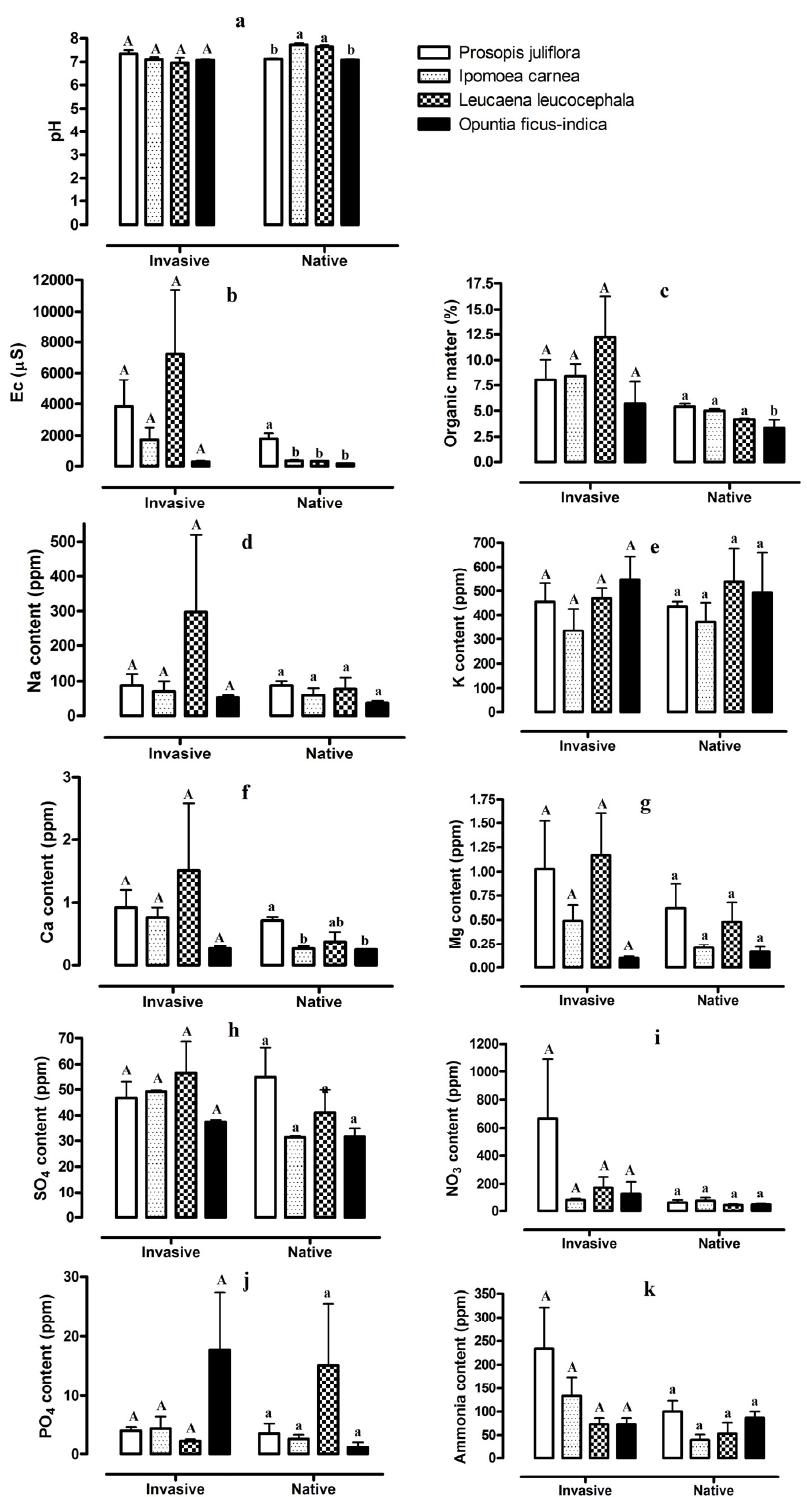
Figure 1. Values of soil properties and ion concentrations, pH ( a ), EC ( b ), organic matter [OM] ( c ), Na ( d ), K ( e ), Ca ( f ), Mg ( g ), SO 4 ( h ), NO 3 ( i ), PO 4 ( j ), and ammonia ( k ), from stands invaded by Prosopis juliflora , Ipomoea carnea , Leucaena leucocephala , and Opuntia ficus-indica and adjacent stands of native vegetation in southwest Saudi Arabia. Different capital letters indicate significant differences among the soils from the stands invaded by four invasive plant species and different lower-case letters indicate significant differences among the soils from stands of native vegetation ( n = 6, p <